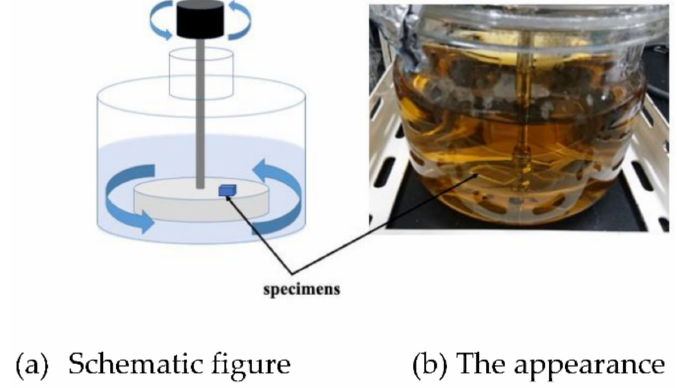
Figure 2. Rotating-platform-driven LBR.